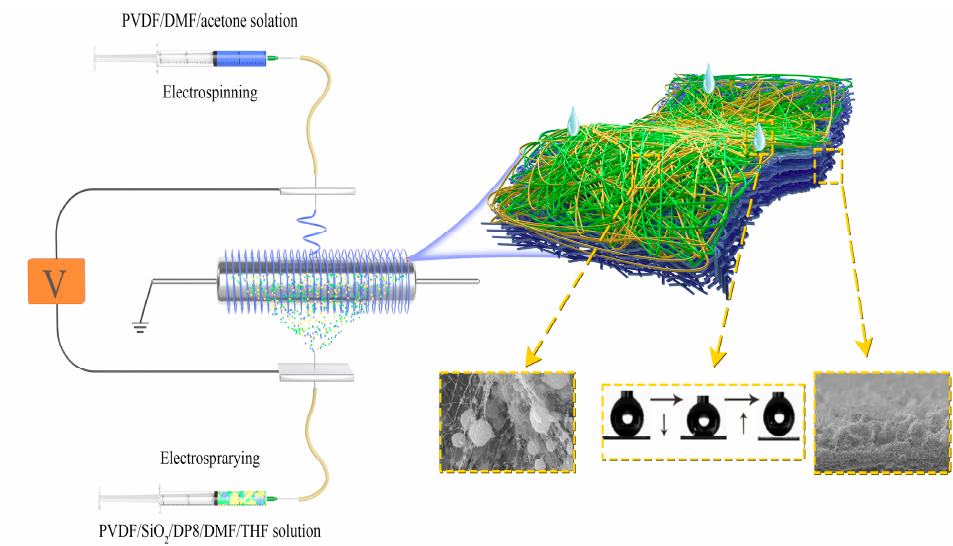
Figure 11. Hydrophobic model of PVDF/DP8/SiO 2 composite membrane.